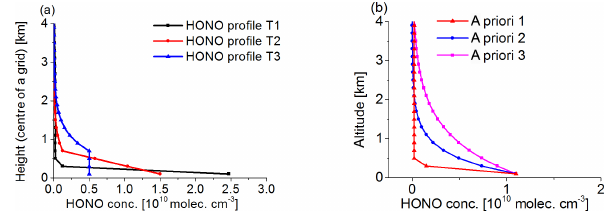
Figure 1. (a) Assumed HONO profiles used for the RTM simula- tions of the HONO delta SCDs. (b) Three different a priori pro- files which were used for the sensitivity studies based on synthetic HONO delta